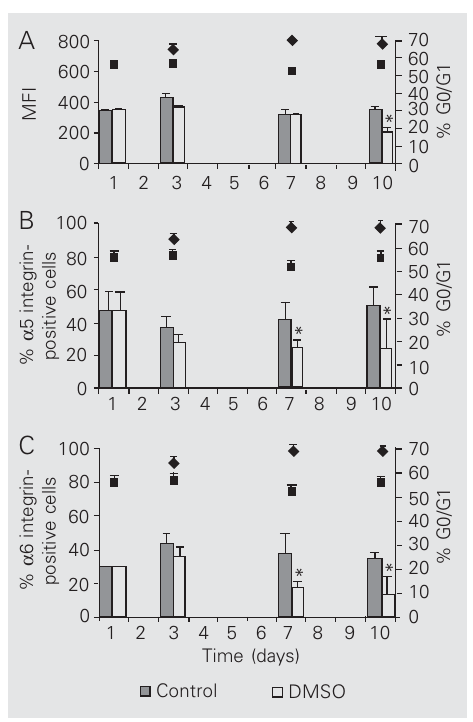
Cells were incubated with specific monoclonal antibodies (mAbs) and analyzed by flow cytometry as described in Material and Methods. Data are reported as percent of integrin-positive cells and mean fluorescence intensity (MFI). Data are the mean ± SD for 5 experiments. *P < 0.05 compared to control